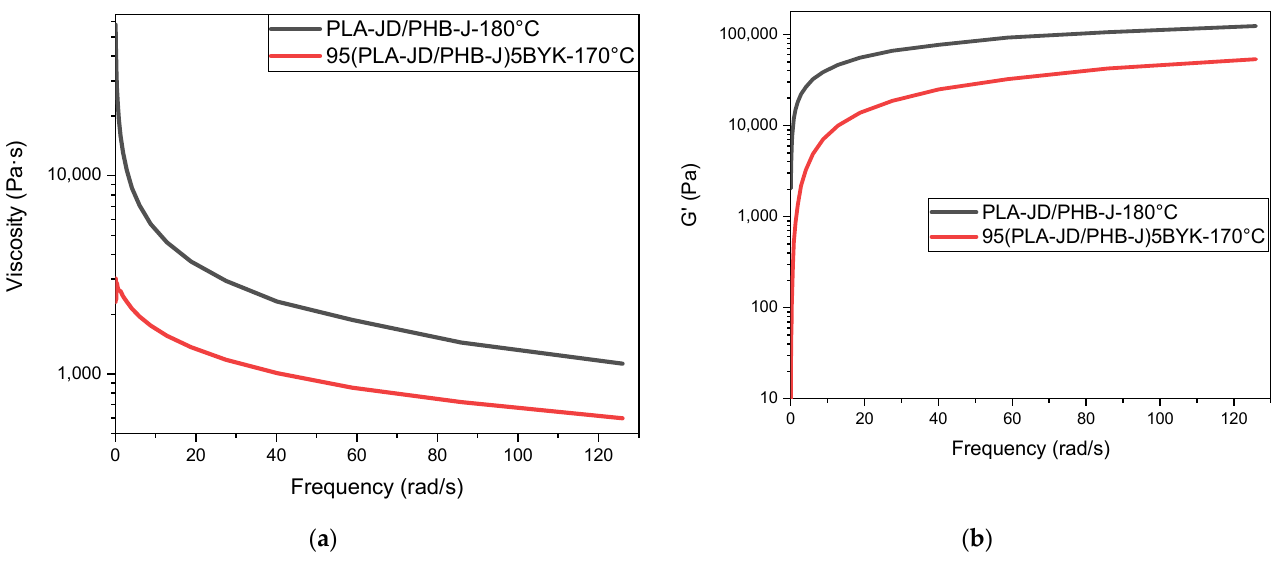
Figure 12. ( a ) Complex viscosity and ( b ) storage modulus in relation to the angular frequency of PLA-JD/PHB-J, and 95(PLA-JD/PHB-J)5BYK blends. Figure 12a shows shear thinning behavior for the two samples tested. Shear-thinning indicates that the blends initially behave as a solid at low frequencies and as a fluid at high frequencies [34]. Figure 12b shows that the storage modulus increases significantly at low frequencies and tends toward a stabilization value above 20 rad/s. Figure 12a,b highlight that the viscosity of the sample and the storage modulus decrease when blends are filled with OMLS, despite a lower analysis temperature. These results may also be associated with the degradation of PHB-J since the clay should act as a reinforcing